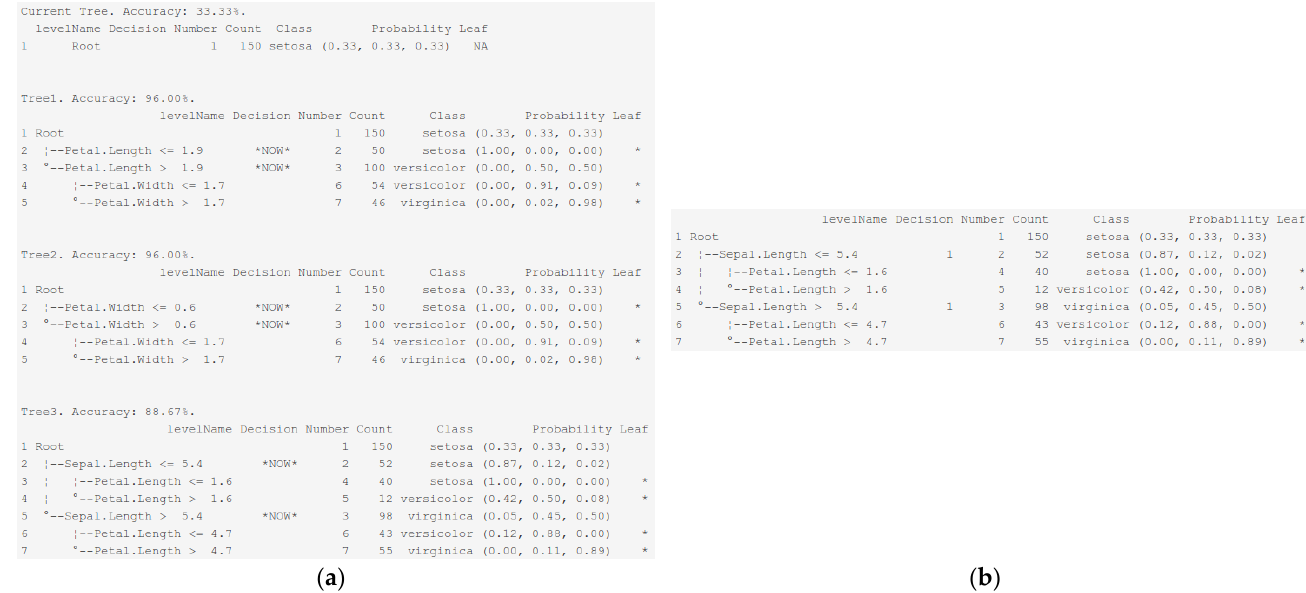
Figure 5. ( a , b ) Exemplary steps for interactive tree learning using the first type of ambiguity for the Iris data set.